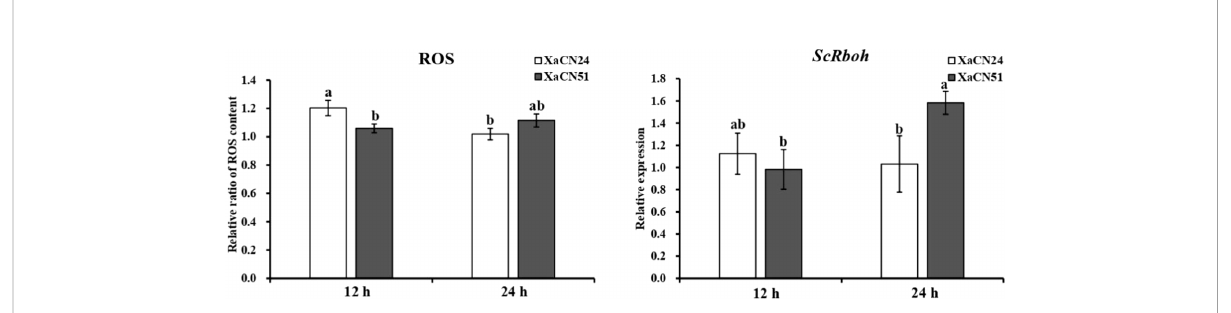
FIGURE 5 Changes of relative ratio of reactive oxygen species (ROS) content and relative expression of gene ScRboh gene in sugarcane leaves inoculated with two strains of Xanthomonas albilineans (XaCN24 and XaCN51). Each vertical bar represents the mean ± standard deviation of fi ve (ROS) or three ( ScRboh ) leaf subsamples collected 12 and 24 hours after inoculation and three technical replicates per subsample. Each leaf subsample is issued from a pooled sample of fragments collected from 35 inoculated leaves. Means with the same letter are not signi fi cantly different at P = 0.05 according to Duncan ’ s test.